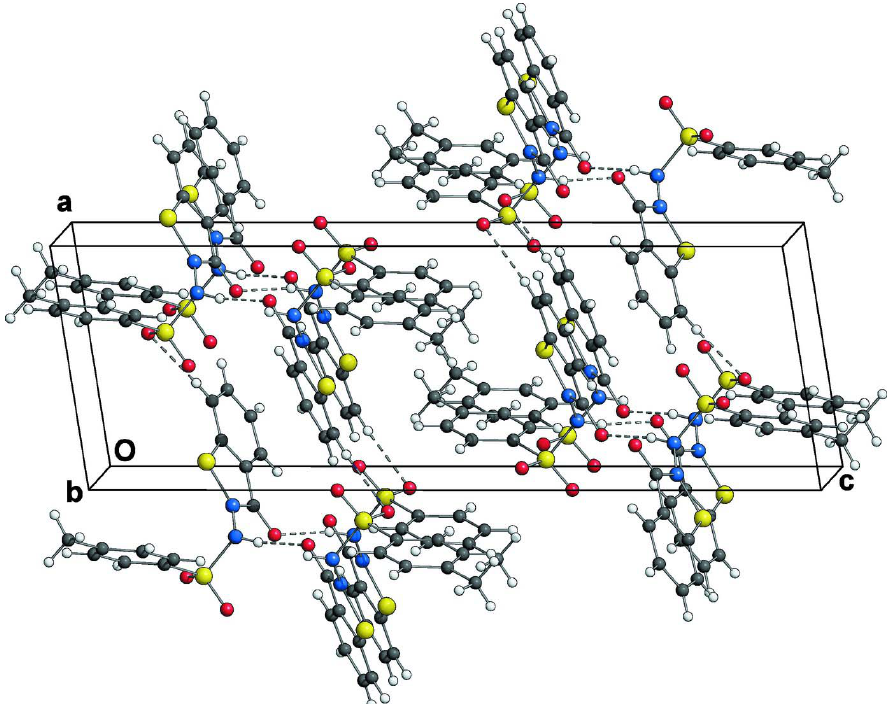
Figure 2 Crystal packing of the title compound viewed approximately along the b axis. Intemolecular N—H···O and C–H···O hydrogen bonds are shown as dashed